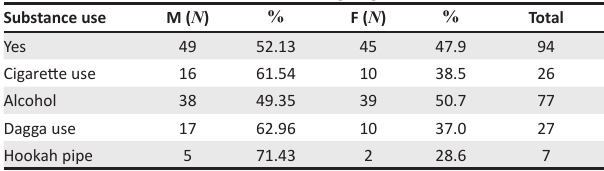
TABLE 3: Patterns of substance use according to